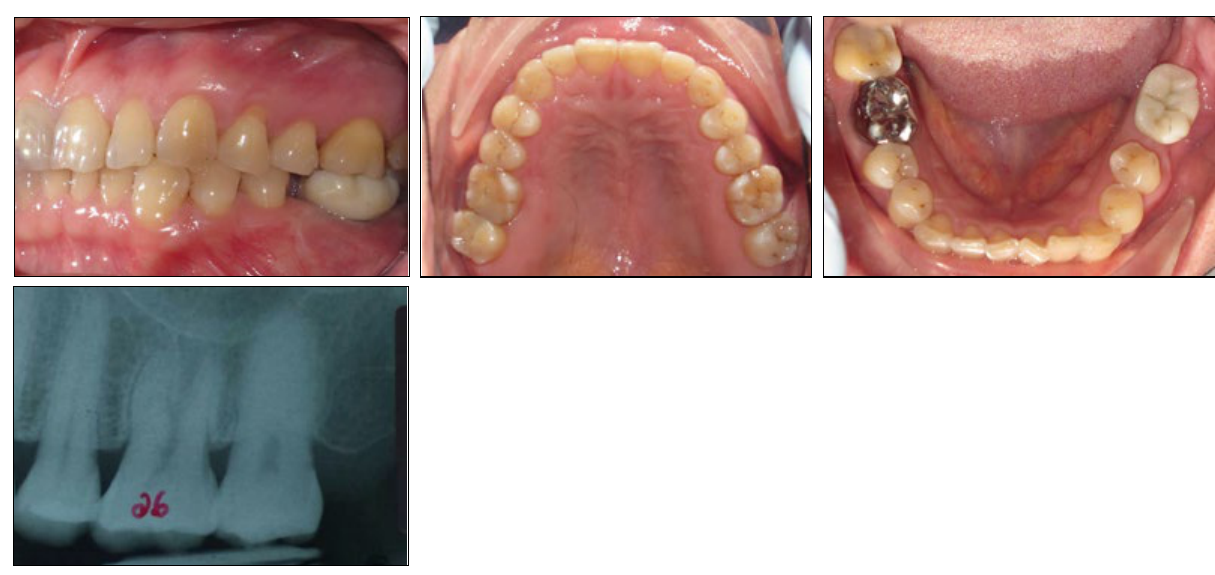
10Fig. 9a and a Beneplate with a 0.032” wire serving as an intrusion lever arm. 11Fig. Fig.9b